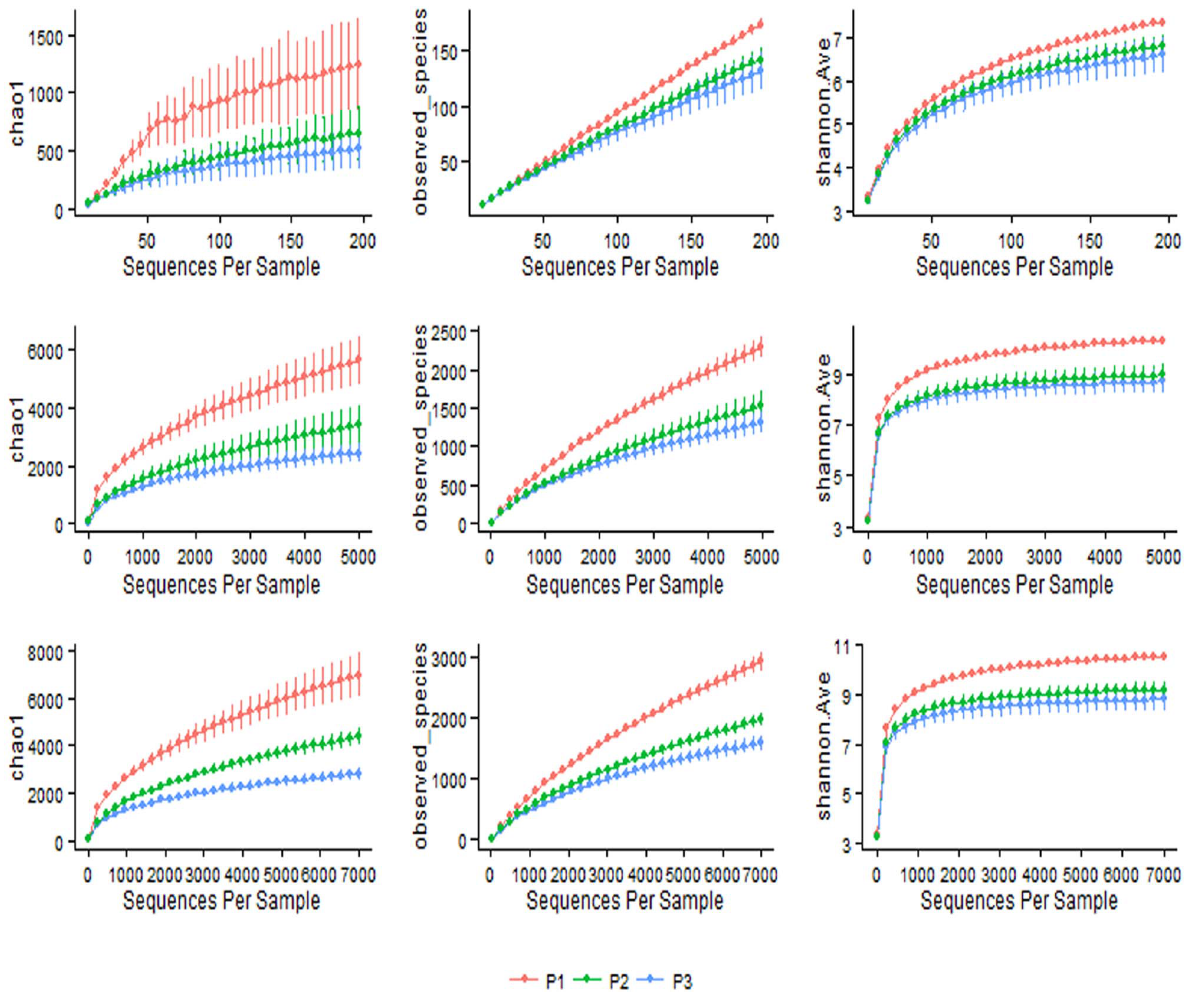
Figure 1. Rarefaction plots for three different primer pairs. Sequence depths a) 200, b) 5000 and c) 7000 displaying species richness (Chao 1 and Observed species) and phylogenetic relationship (Shannon index); (P1: targeting V1–V3 region; P2: targeting V4–V5 region and P3: targeting V6– V8 region).